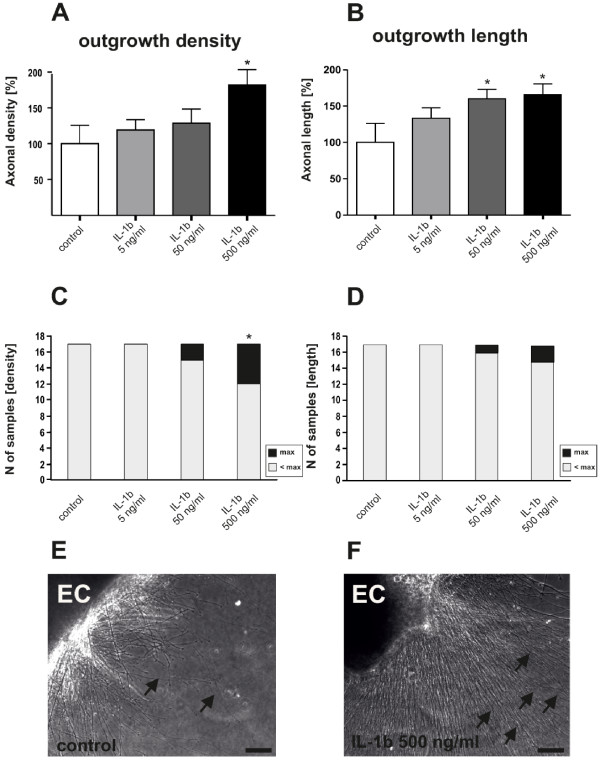
IL-1β stimulates neurite density and length in organotypic brain slices. A dose-response curve revealed that high doses of IL-1β (500 ng/ml) added to the culture medium, stimulate neurite density (A) of organotypic brain slices and the amount of slices reaching the maximum outgrowth (C). A lower dose (50 ng/ml) is still able to stimulate the average length of neuritis (B) but neither 500 ng/ml nor 50 ng/ml of IL-1β were able to significantly increase the amount of slices presenting maximum length (D). E + F: representative photomicrograph showing the increase in outgrowth of IL-1β treated EC compared to control. n = 17 slices. A + B: *: Statistically significant difference to control; p < 0.05 (Mann Whitney U test). C + D: *: Statistically significant difference; p < 0.05 (Chi-square analysis) EC = enthorinal cortex. Arrows indicate neuritis. Scale bar: 100 μm.